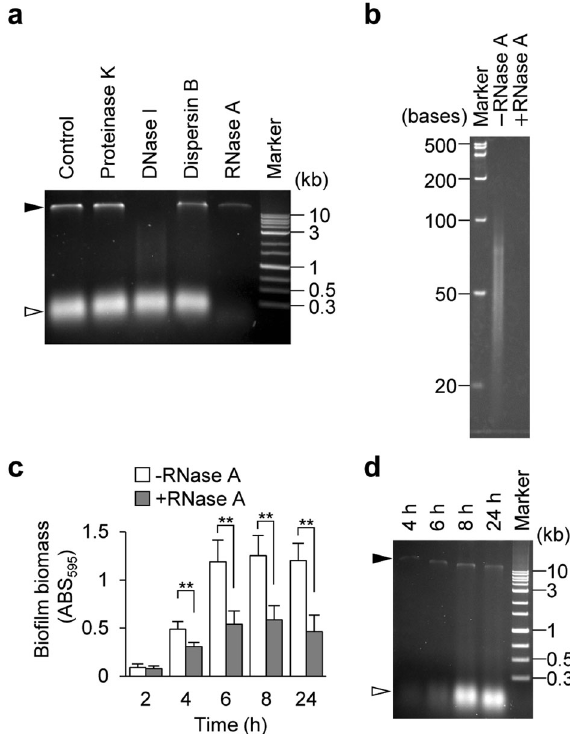
Fig. 2 Extracellular RNA is present in the Staphylococcus aureus bio fi lm matrix. a A bio fi lm matrix extracted from 24-h bio fi lms of MR10 was treated with the indicated enzymes or left untreated (Control); nucleic acids were separated on agarose gels. b RNA size was estimated using urea-denaturing polyacrylamide gel electro- phoresis. The sample after treatment with RNase A was also loaded as a control. c MR10 bio fi lms formed at the indicated time points (hours) were treated with RNase A (gray bars) or left untreated (white bars) with RNase A. The data are presented as the mean and standard deviation (error bar) of three independent experiments. ** P < 0.01. d A bio fi lm matrix was isolated from the bio fi lms at the indicated time points (hours) and the presence of nucleic acids was determined using agarose gel electrophoresis. The applied volume was standardized by bio fi lm wet weight (10 μ L of the bio fi lm matrix extracted from 0.44 mg of the bio fi lm was applied per one lane). The white and black arrowheads denote RNA and DNA,